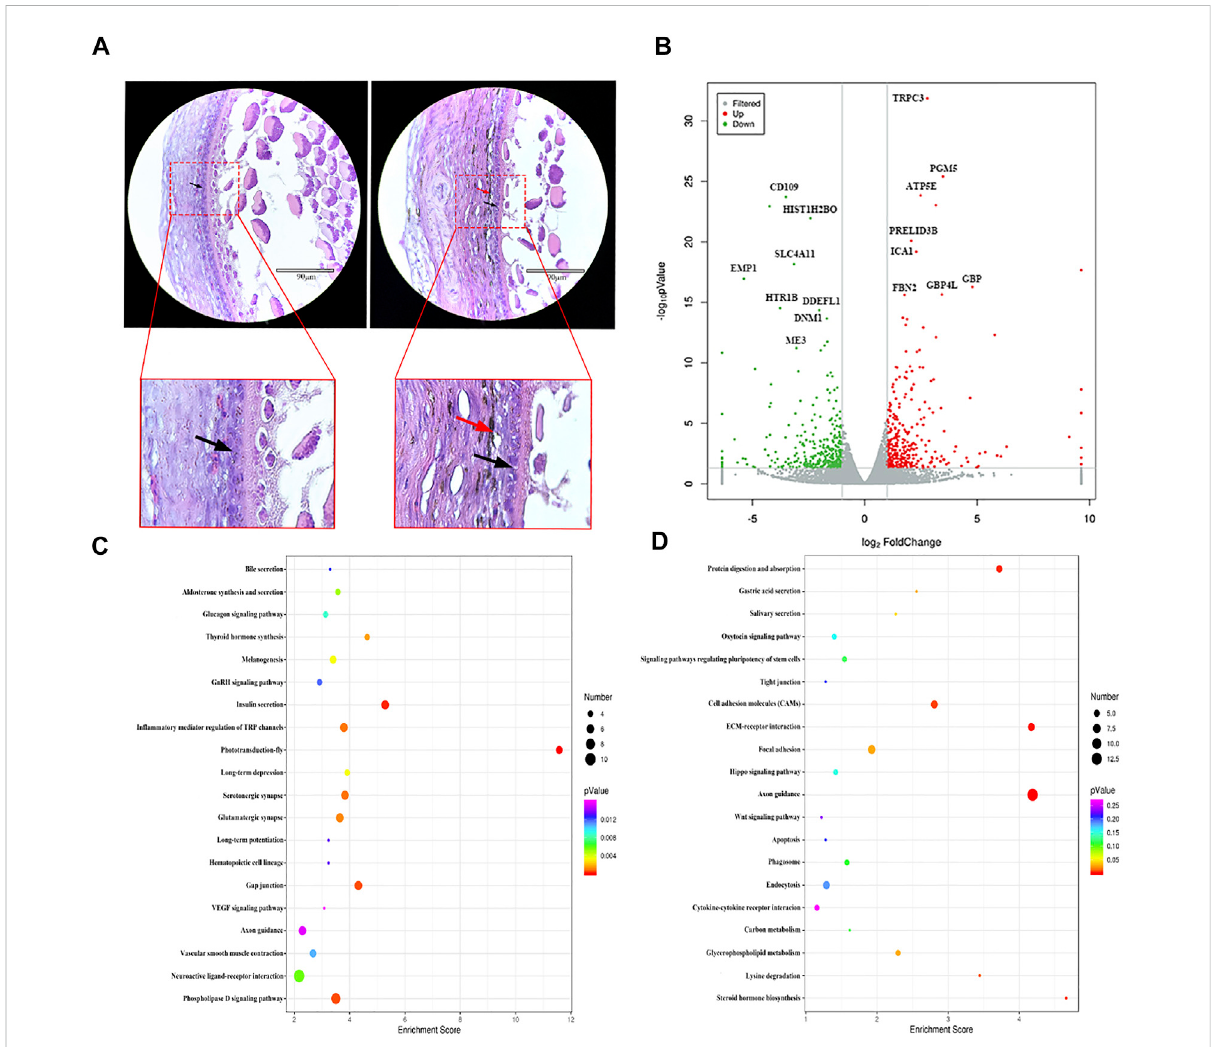
FIGURE 2 Comparison ofgeneexpressiondifferencesbetween WLandSFphGCs. (A) Histological observation ofWL andSFphGCs.(LeftisWL,rightisSF. black arrow, follicle granulosa cells; red arrow, melanocytes). (B) Volcano plot of up- and down-regulated genes. (C) Top 20 KEGG pathway of up- regulatedgenesinSFphGCscomparedwithWLphGCs. (D) Top20KEGGpathwayofdown-regulatedgenesinSFphGCscomparedwithWLphGCs. The x-axis is the enrichment score, the larger the bubble, the greater the number of genes encoding differential proteins. The color of the dots represents the range of q